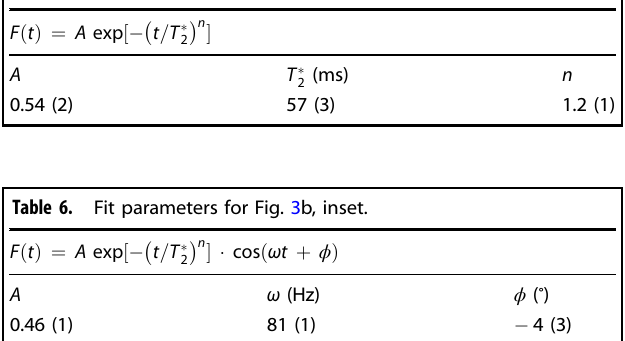
Table 5. Fit parameters for Fig. 3b, main panel.